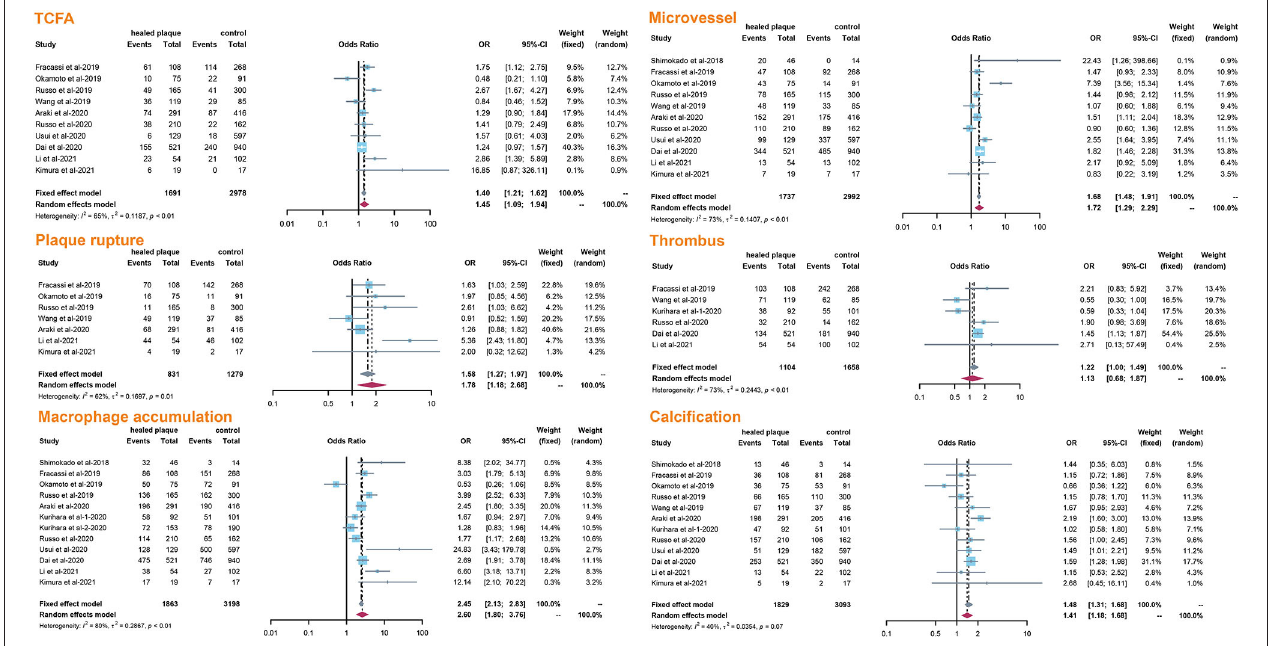
FIGURE 2 | Summary of qualitative characteristics of healed plaques in the total population. TCFA, thin-cap fibroatheroma.